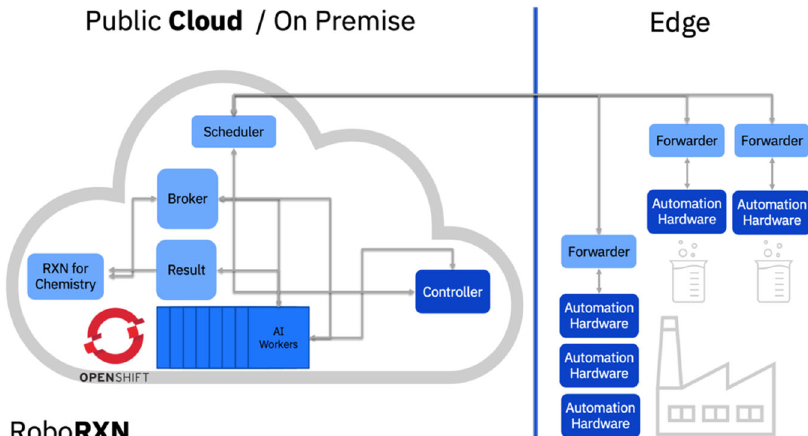
Fig. 6 The architectural design of the AI-powered, Cloud-based autonomous chemical laboratory. The prototype is made up of two parts. The fi rst one which includes AI, Frontend and Backend components can live either in the Cloud or Premise thanks to the OpenShift technology that allows a seamless portability across different infrastructures. The second one comprising automation hardware physically located on the edge behind a fi